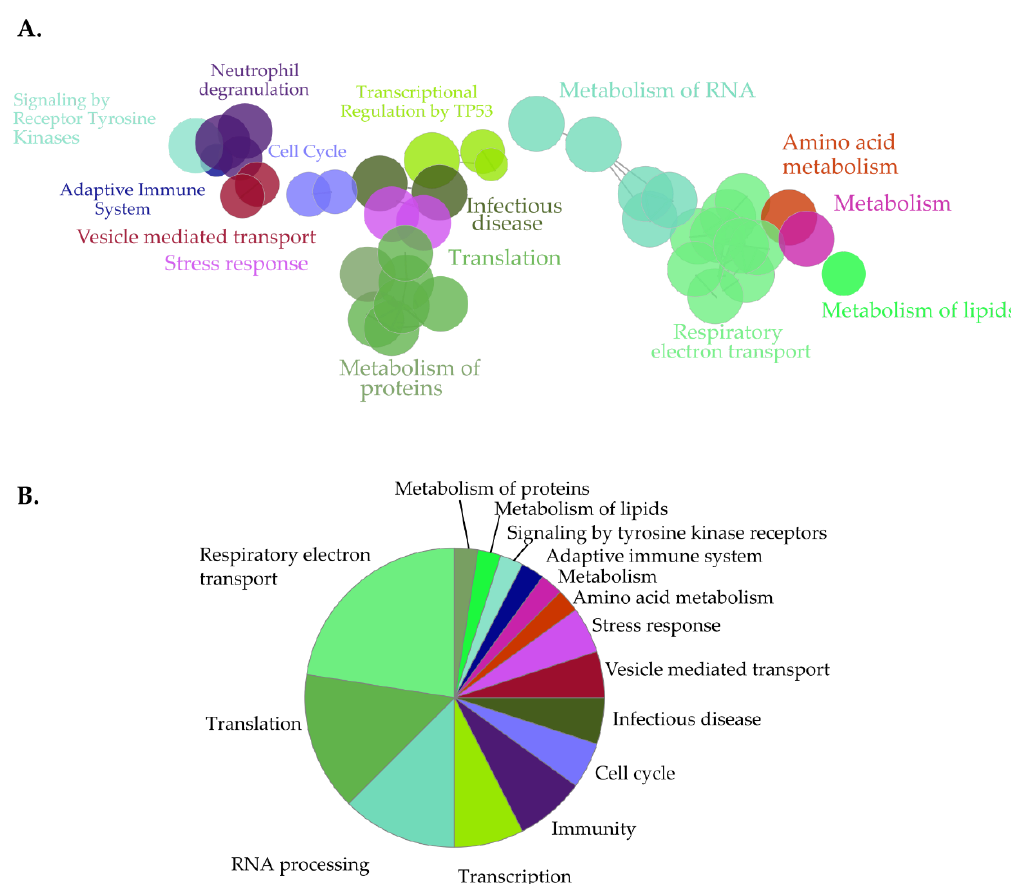
Figure 6. Clustered pathway analysis of SN214-BioID proximal interactors. ( A ) Functionally grouped network of SN214-BioID proximal interactors. Nodes correspond to functional clusters resulting from term grouping based on their overlapping level. ( B ) Overview pie-chart with functional groups. Statistical analysis was performed with the Cytoscape plugin ClueGo (v2.5.5) using the hypergeometric test and the following parameters: p < 0.01, kappa-score (k) = 0.5; (min / %) genes = 40 / 4%, GO tree levels: 13-15. Ontology databases: GOBP, GOCC, and GOMF, Reactome Pathways and KEGG.